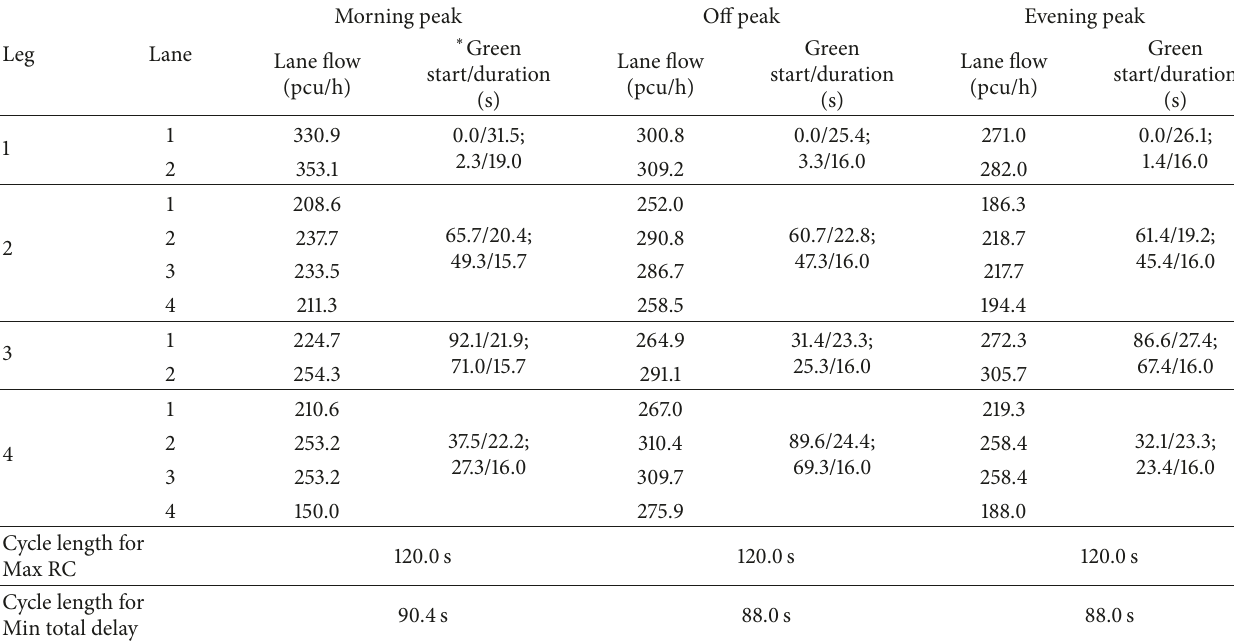
Table 8: Key signal optimization results from the multiperiod lane-based model as current model